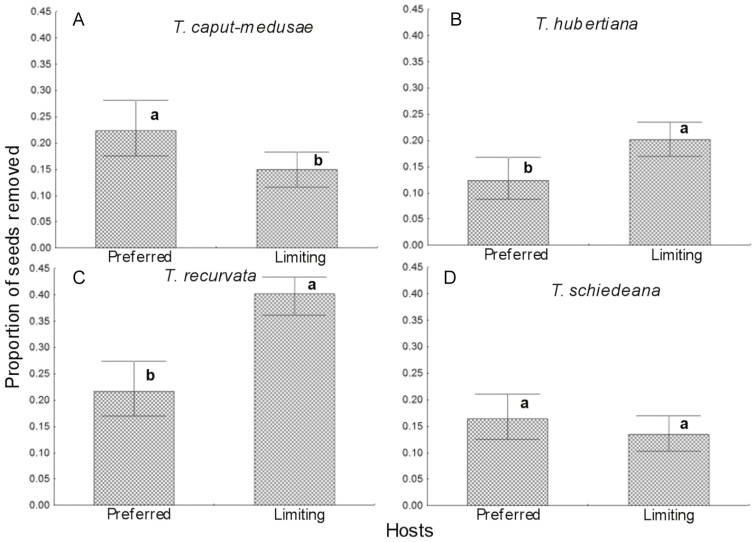
Proportion of removed seeds of four epiphyte species grouped into preferred (Bursera copallifera, B. bipinnata) and limiting (B. fagaroides, Ipomoea murucoides and I. pauciflora) host species. Different letters denote significant differences in seed depredation among host species. The lines of dispersion are binomial 95 % confidence intervals.